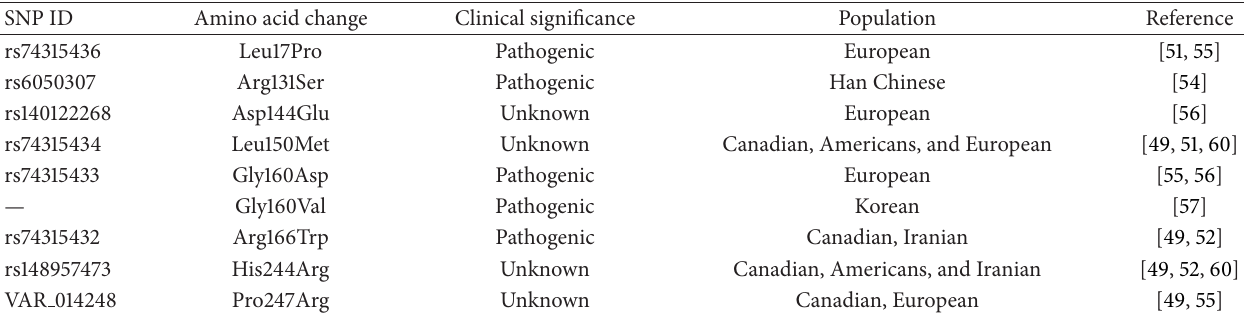
Table 3: Common VSX1 variants reported in patients with